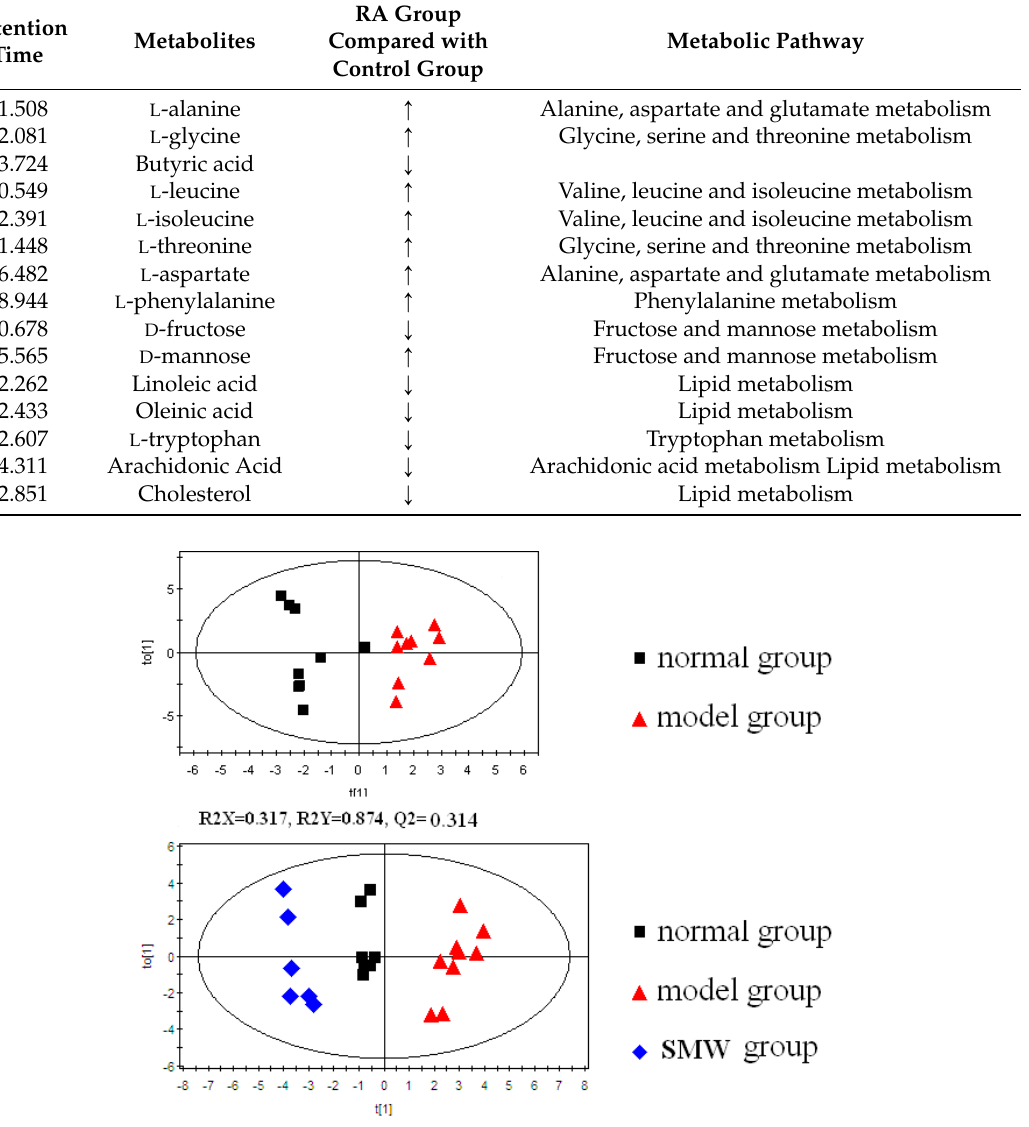
Table 2. Metabolites of variable importance for projection (VIP) > 1 in normal group and model group.